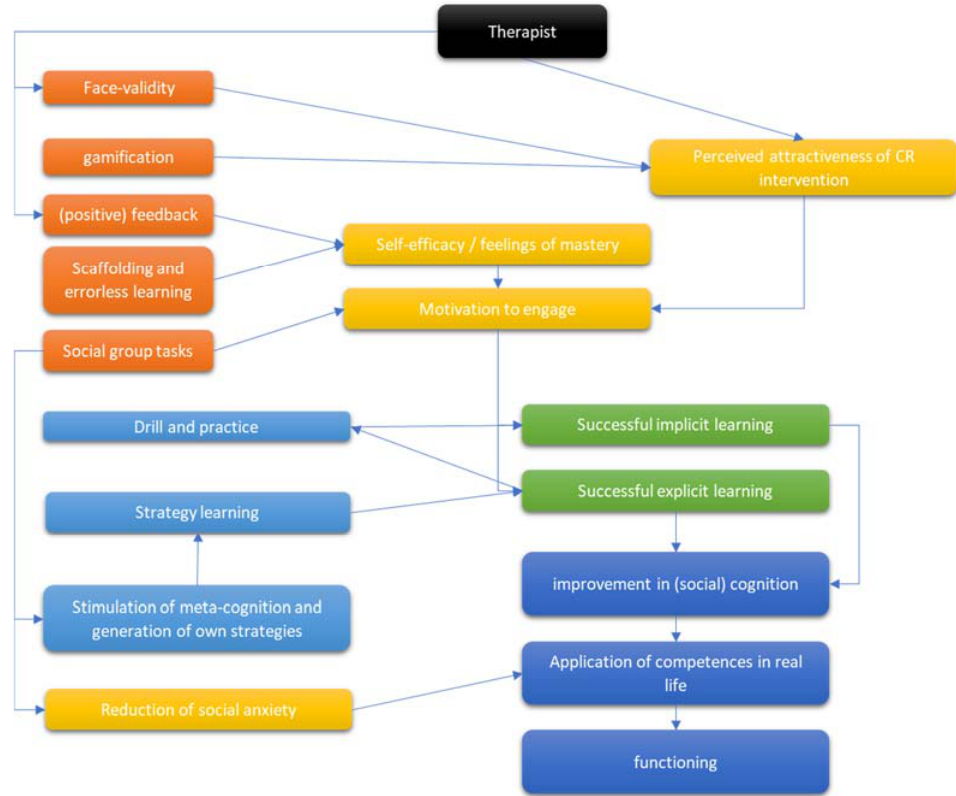
Figure 3. Interaction between key variables in CR settings. Yellow: moderating or mediating non- cognitive variables; orange: features of the CR tasks; light blue: features of the CR intervention; green: types of learning; dark blue: effects of the CR intervention.